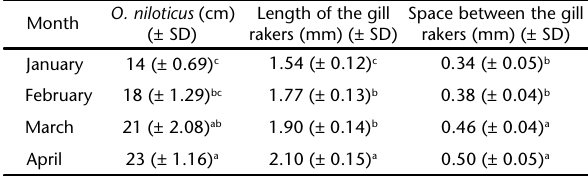
Table 1. Zooplankton community and respective size variations found in the diet of post-larval stages (juvenile to adult) of Oreochromis niloticus throughout four months.